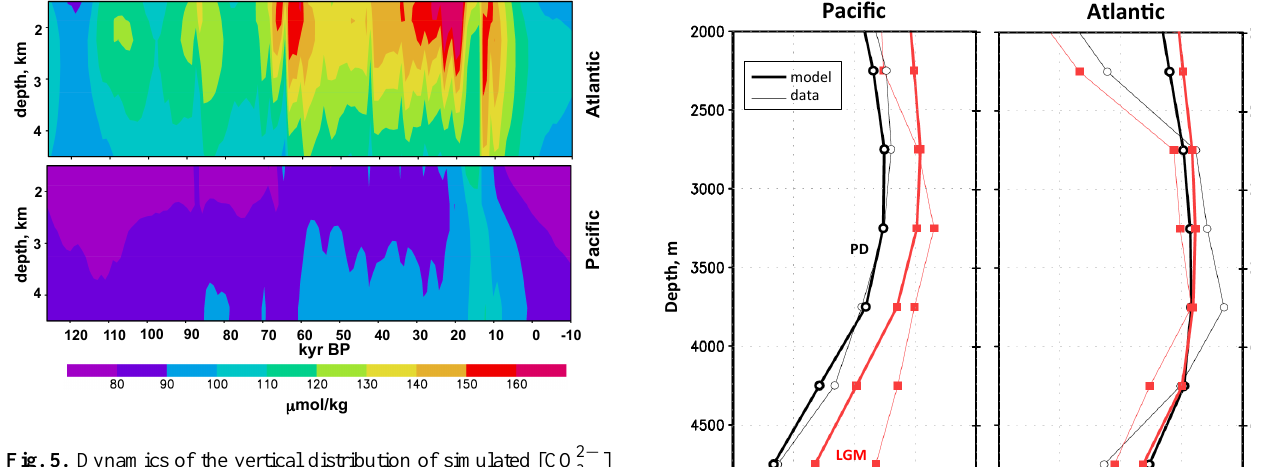
Fig. 5. Dynamics of the vertical distribution of simulated [CO 2 − concentration in the deep ocean (in µmolkg − 1 ) averaged over 30 ◦ S–30 ◦ N: Atlantic Ocean (top panel); Pacific Ocean (bottom panel).